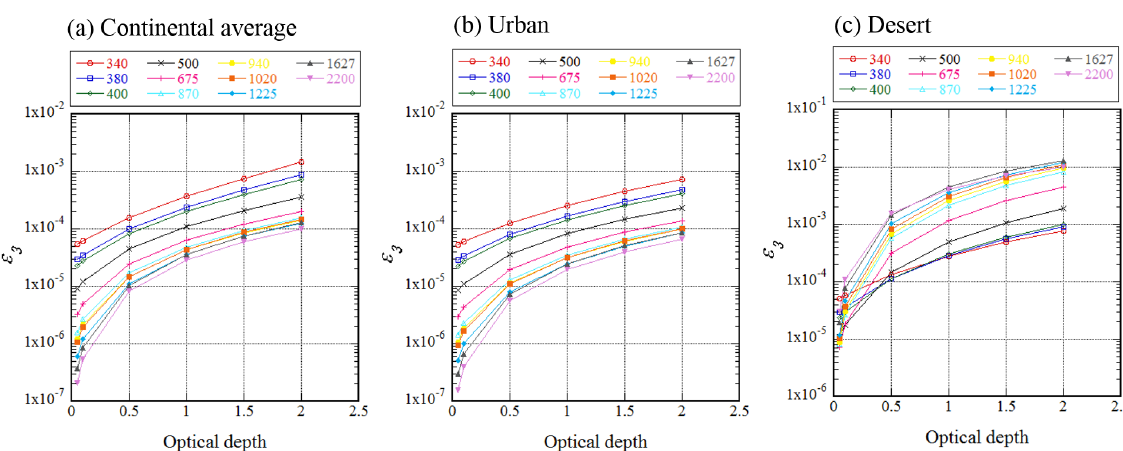
Figure 3. Same as Fig. 2 but for error ε 3